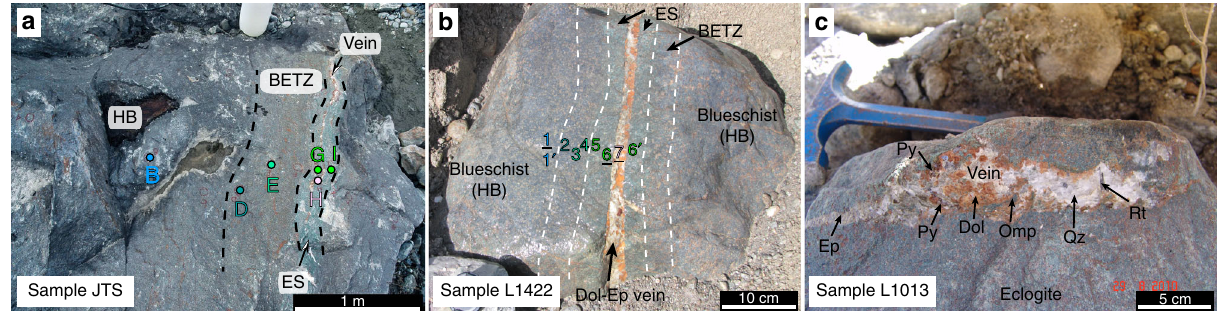
Fig. 1 Field photographs of three sul fi de-bearing veins in blueschists/eclogites (SW Tianshan). a Sample JTS containing host blueschist (HB), blueschist – eclogite transition zone (BETZ), eclogite selvage (ES) and vein. Six drill samples (JTS-B, -D, -E, -G, -H, -I) along the traverse were taken for petrological investigation and chemical measurements. b HB – BETZ – ES – vein system L1422. Nine drill cores (see numbers) along the pro fi le were investigated in this study. Petrological features of underlined drill samples are shown in Fig. 2. c Eclogite – vein sample L1013. Mineral abbreviations: dolomite (Dol), epidote (Ep), omphacite (Omp), pyrite (Py), quartz (Qz), and rutile